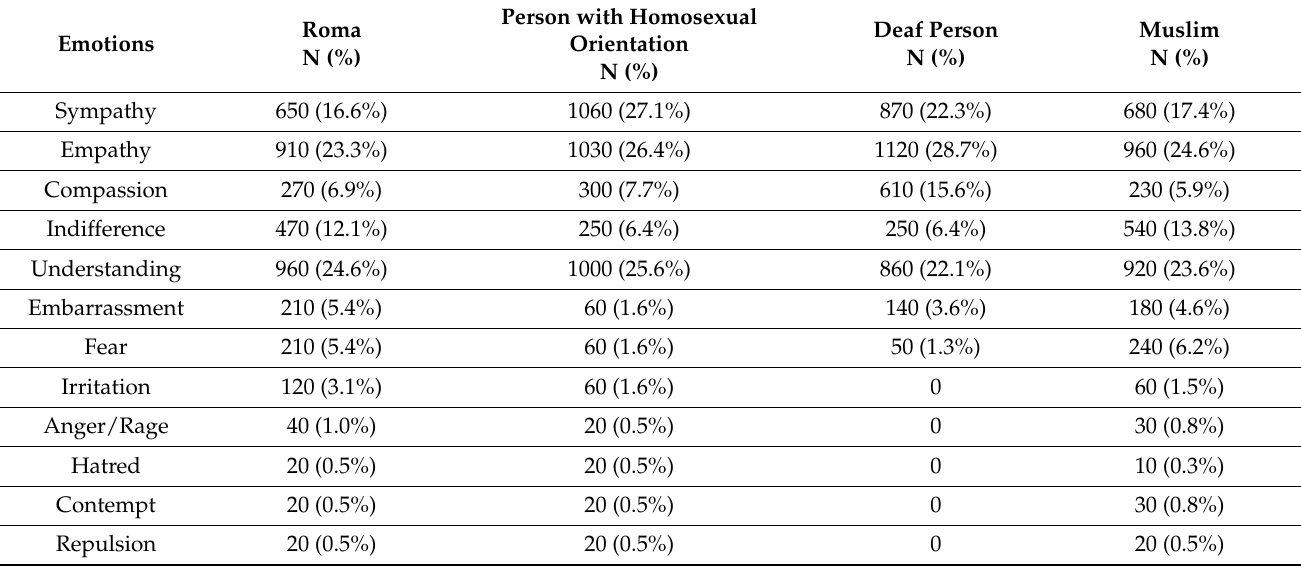
Table 8. Anticipated types of emotions indicated by the respondents while performing their profes- sional duties towards particular social